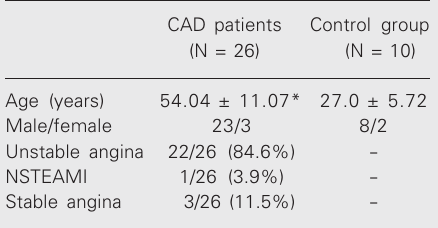
Table 1. Demographic and clinical characteristics of patients with coronary artery disease and a healthy control